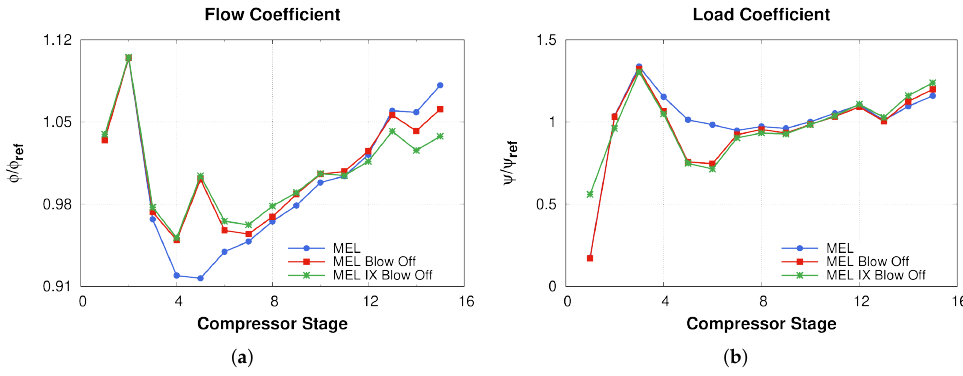
Figure 6. Stage flow coefficient ( a ) and load coefficient ( b